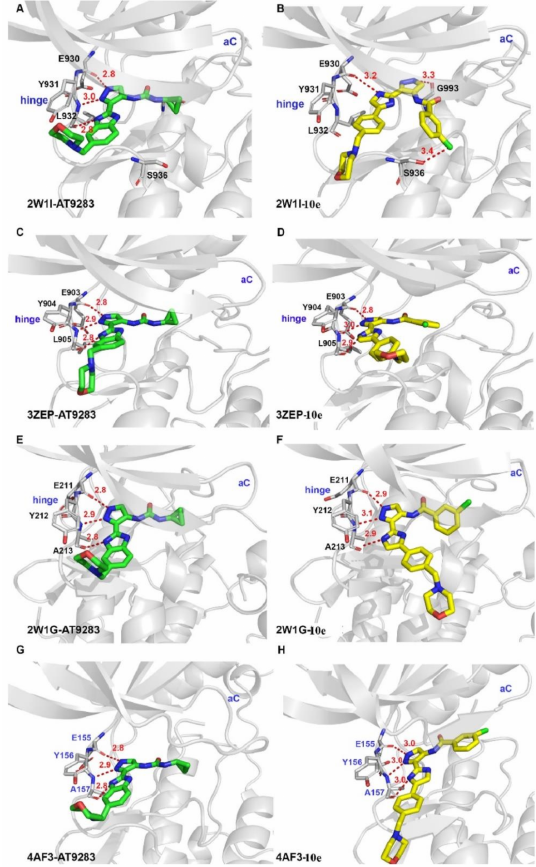
Figure 102. Putative binding interactions of AT9283 and compound 99 . ( A ) AT9283 with JAK2; ( B ) Compound 99 with JAK2; ( C ) AT9283 with JAK3; ( D ) Compound 99 with JAK3; ( E ) AT9283 with Aurora A; ( F ) Compound 99 with Aurora A; ( G ) AT9283 with Aurora B; ( H ) Compound 99 with Aurora B